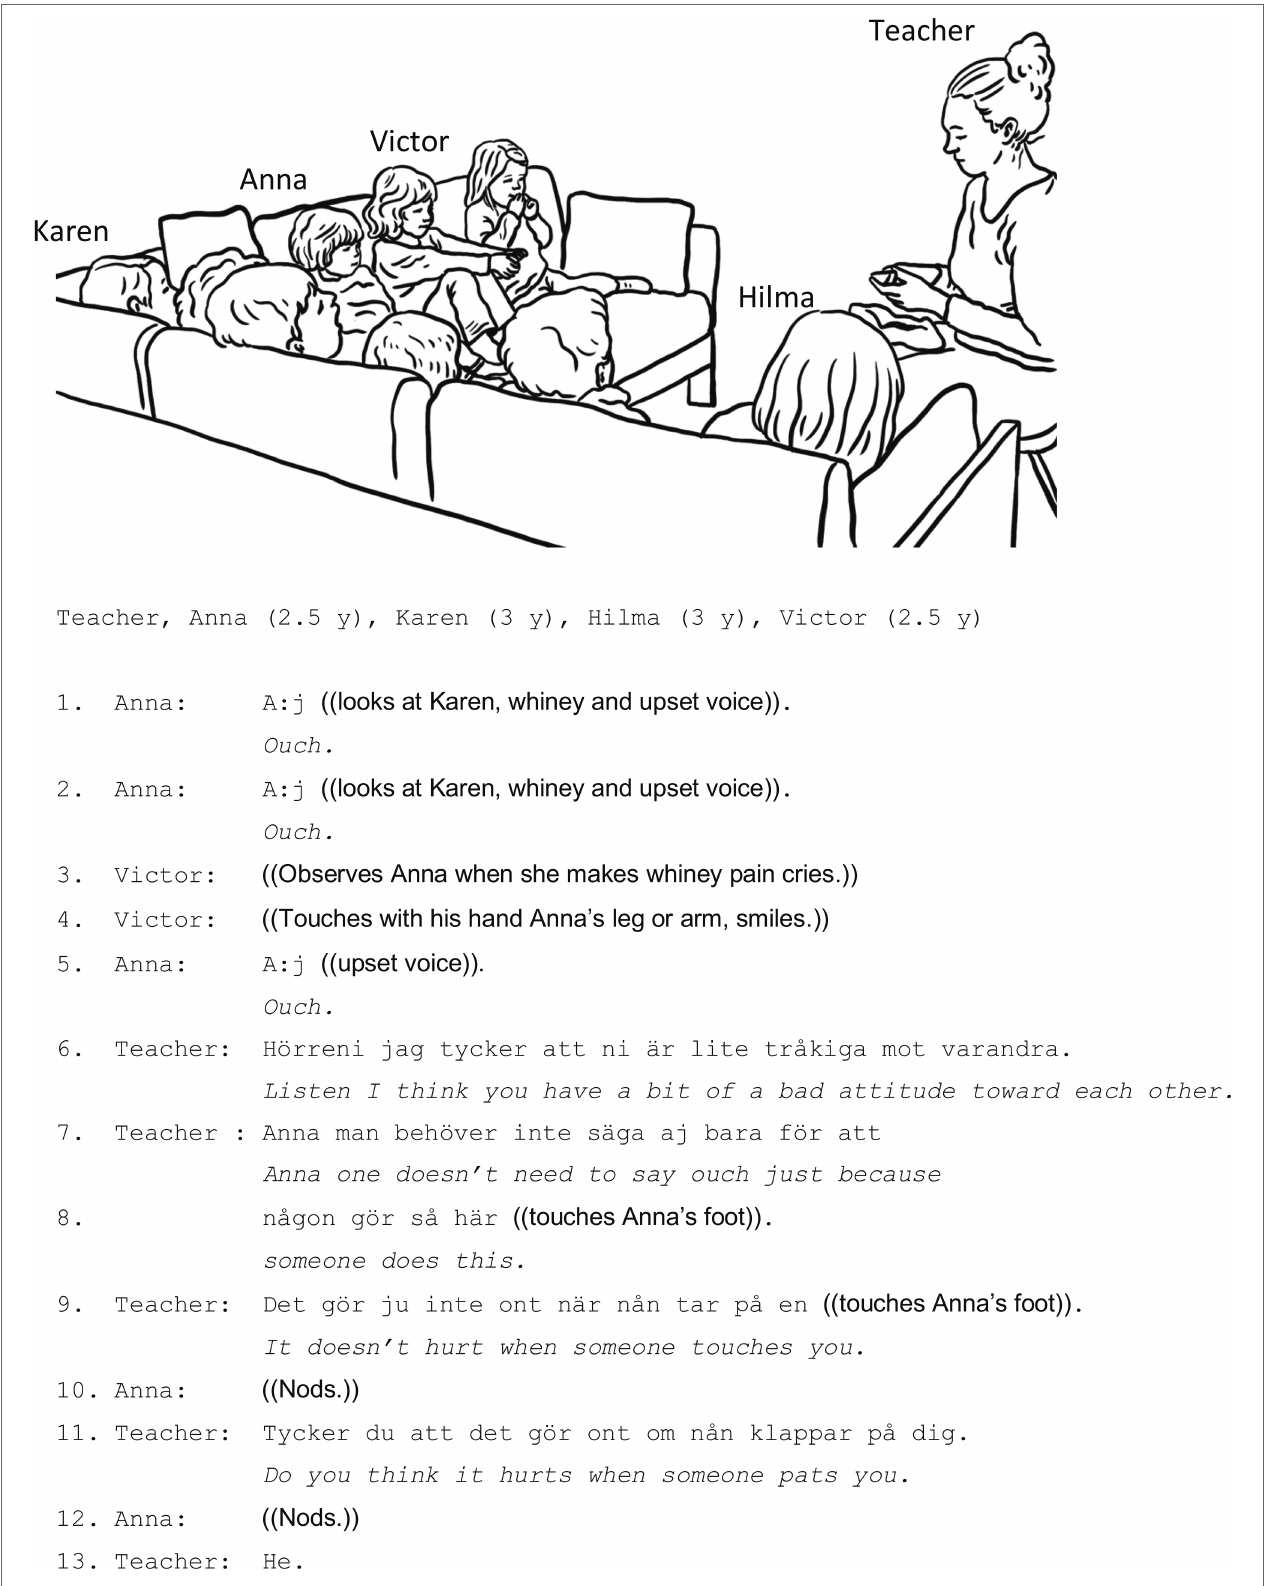
FIGURE 1 | Excerpt